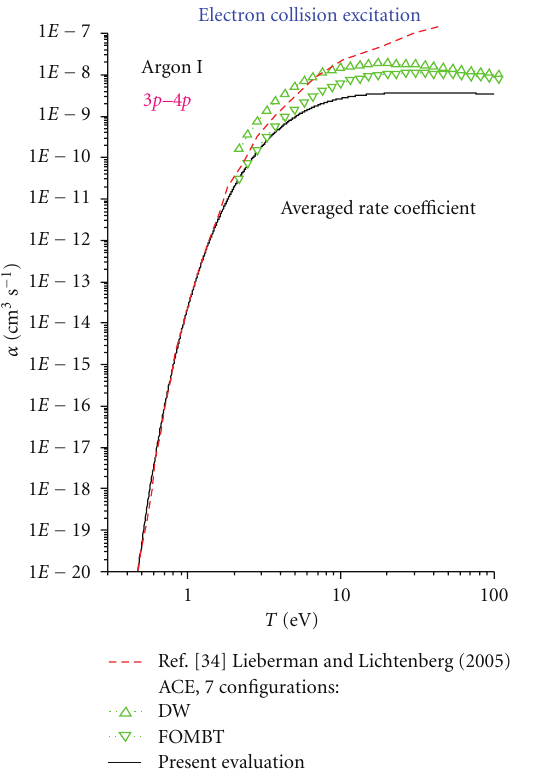
Figure 7: Averaged electron excitation rate coe ffi cient of Ar I 3 p –4 p from 0.3 to 100 eV.